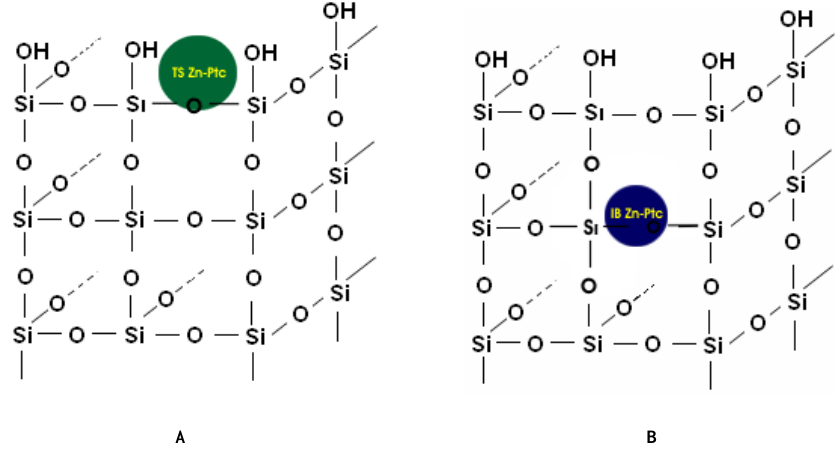
FIGURE 5 . Hypothetical structures of silicate conjugates with: (A) ZnPcTS; (B) TBZnPc (diagrammatic